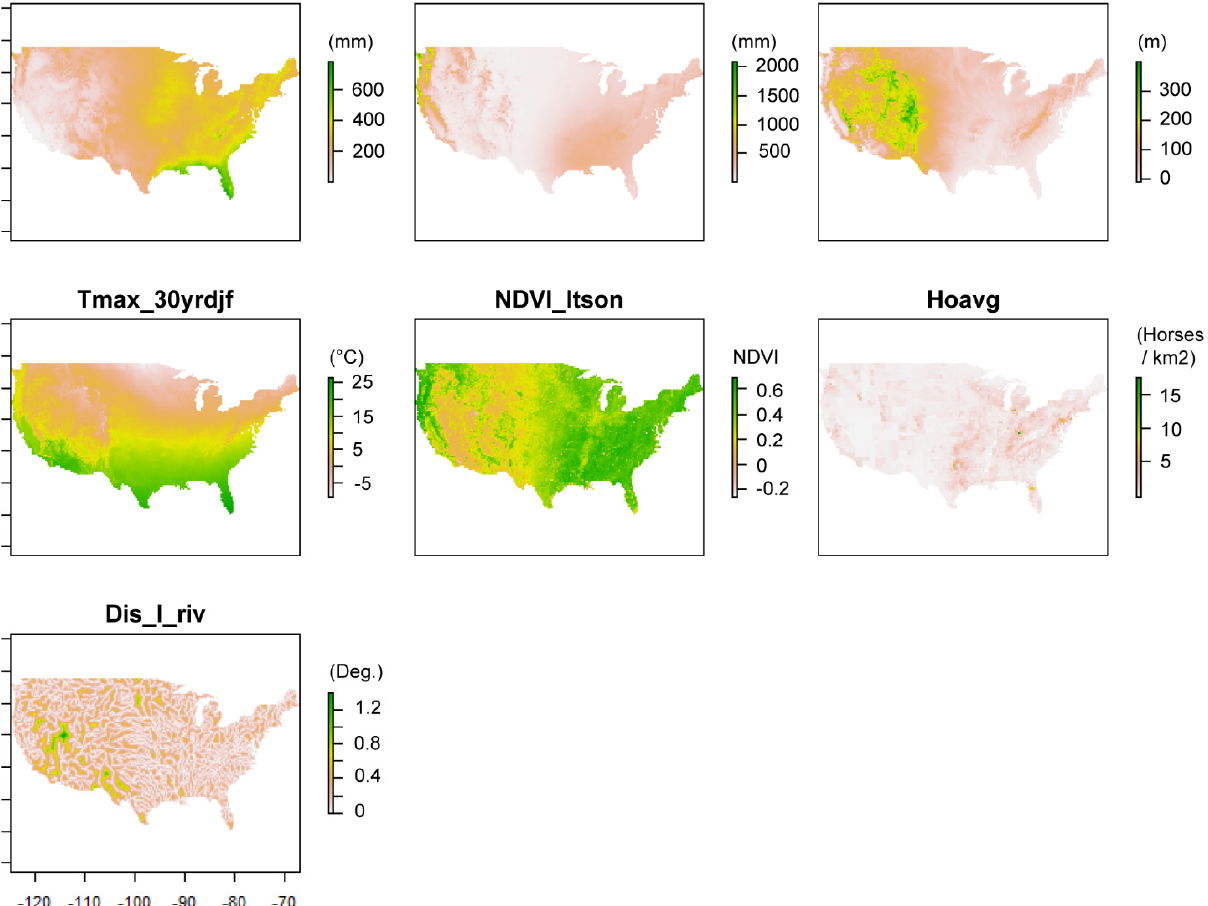
Figure 4. Maps of the environmental variables, ranked by permutation importance (PI), used in the full model under current climate of the current VS distribution. Plots represented the spatial variability of average summer precipitation (PPT_30yrjja, PI = 28.2), average winter precipitation (PPT_30yrdjf, PI = 27.2), elevation (GTOPO_1km, PI = 13.8), average maximum winter temperature (Tmax_30yrdjf, PI = 10.1), average fall NDVI (NDVI_ltson, PI = 8.8), average horse density (Hoavg, PI = 8.6), and distance to water (Dis_l_riv, PI = 3.4).